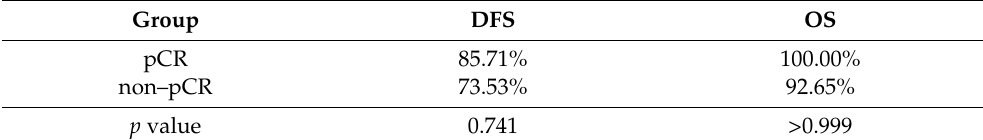
Table 5. Prognostic analysis of patients in the pCR and non–pCR